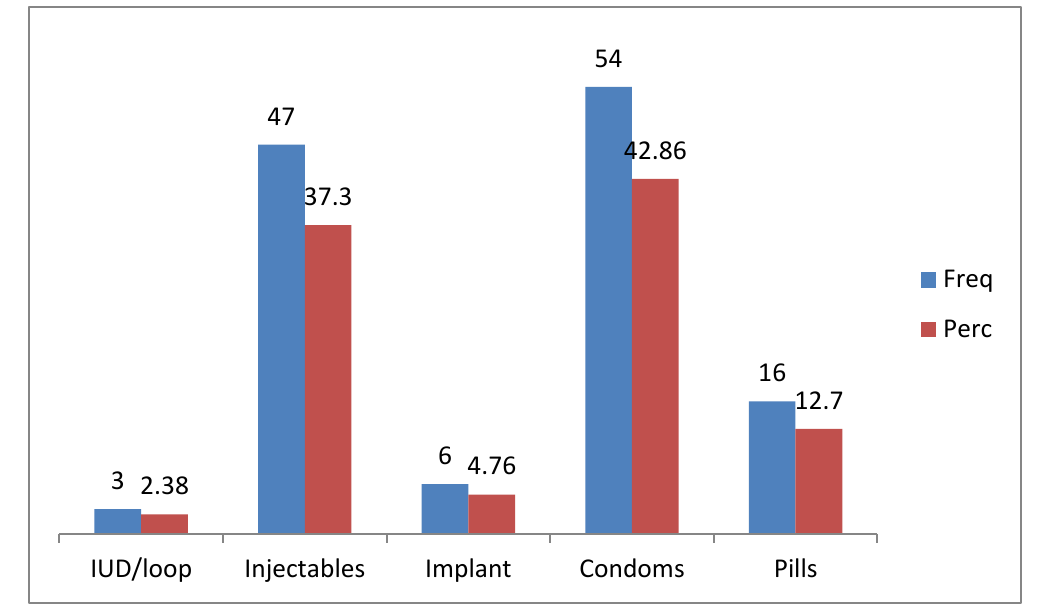
Figure 4. Contraceptive methods (n = 126) used by the participants.